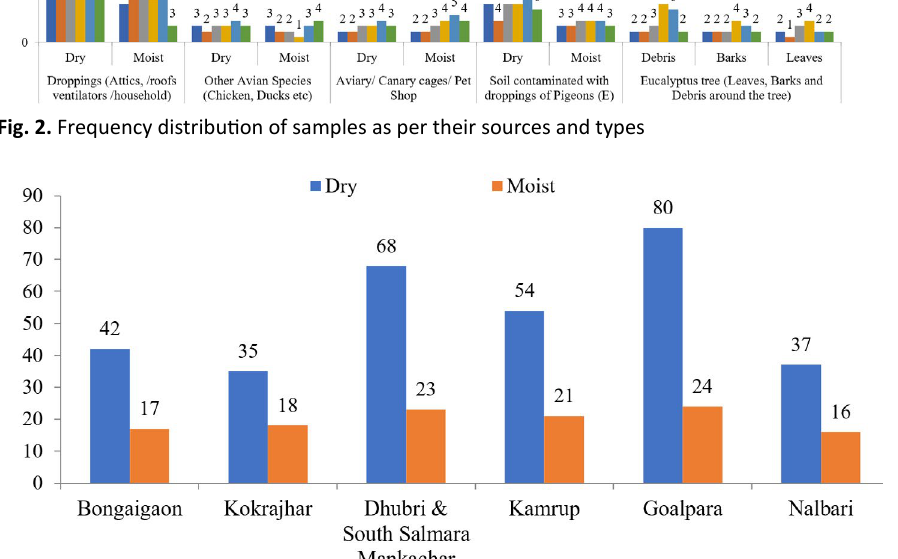
Fig. 3. Distribution of samples collected from different regions and their